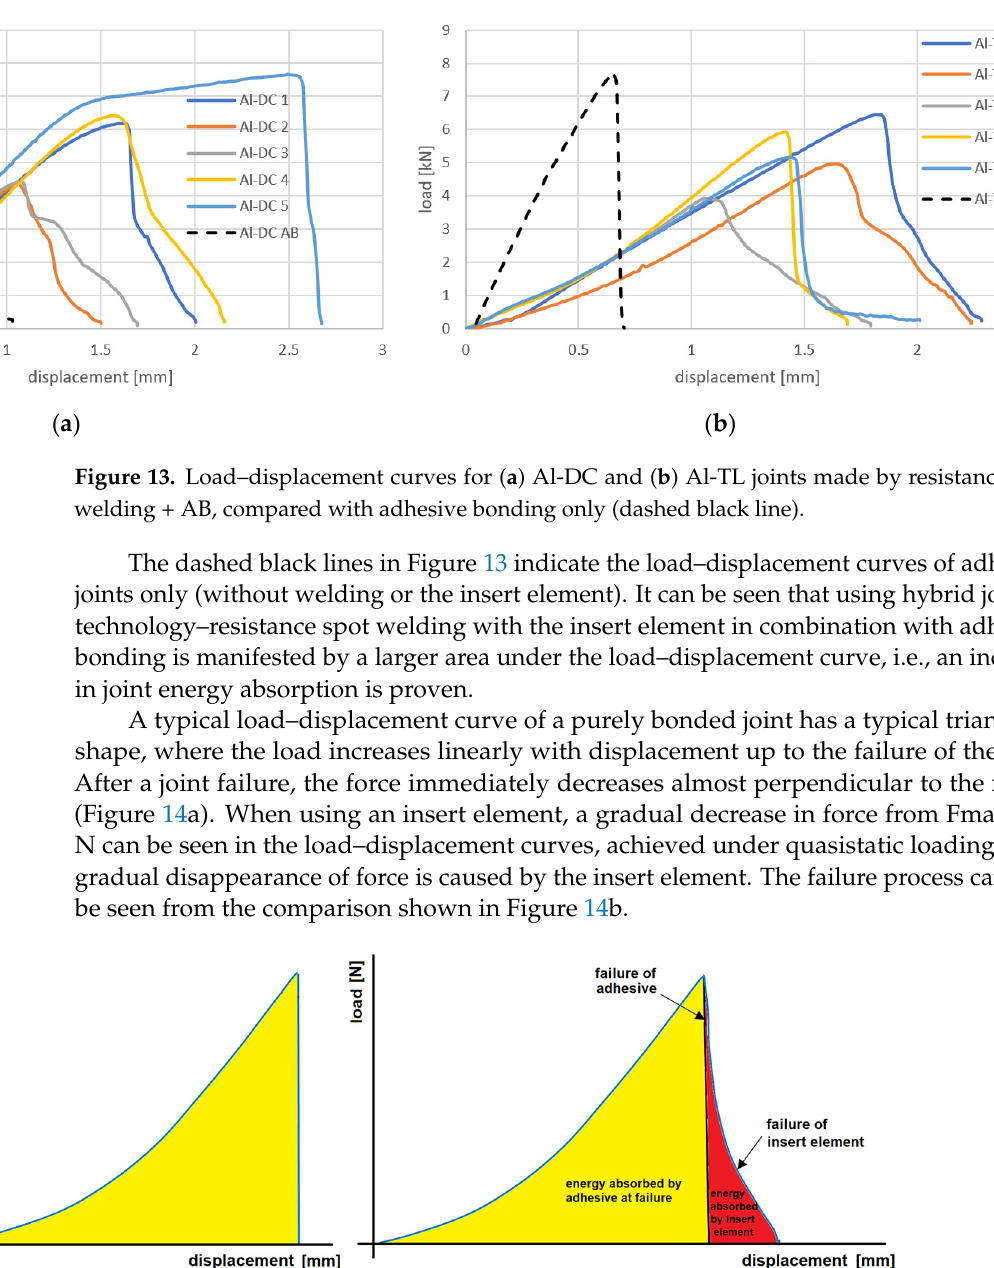
Table 9. Maximum load Fmax [N] and stress σ [MPa] in substrates used in welded-bonded joints (rubber-based adhesive).